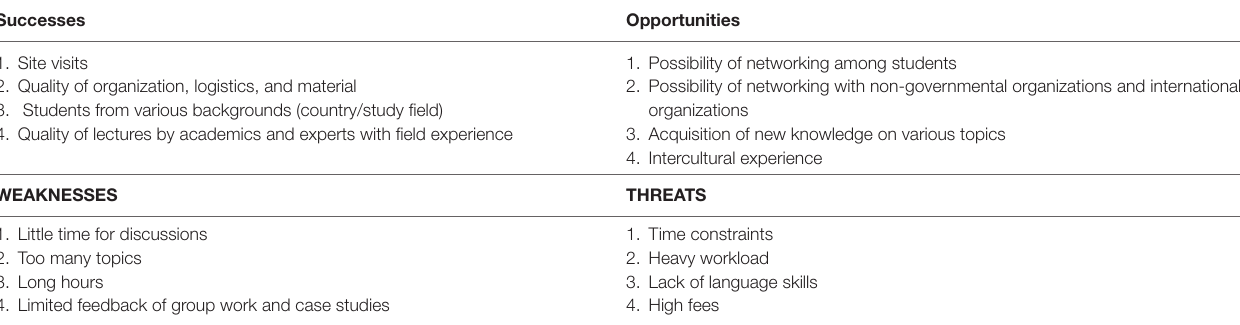
table 5 | Students’ satisfaction via SWOT technique: most frequently mentioned points ranked from 1 to